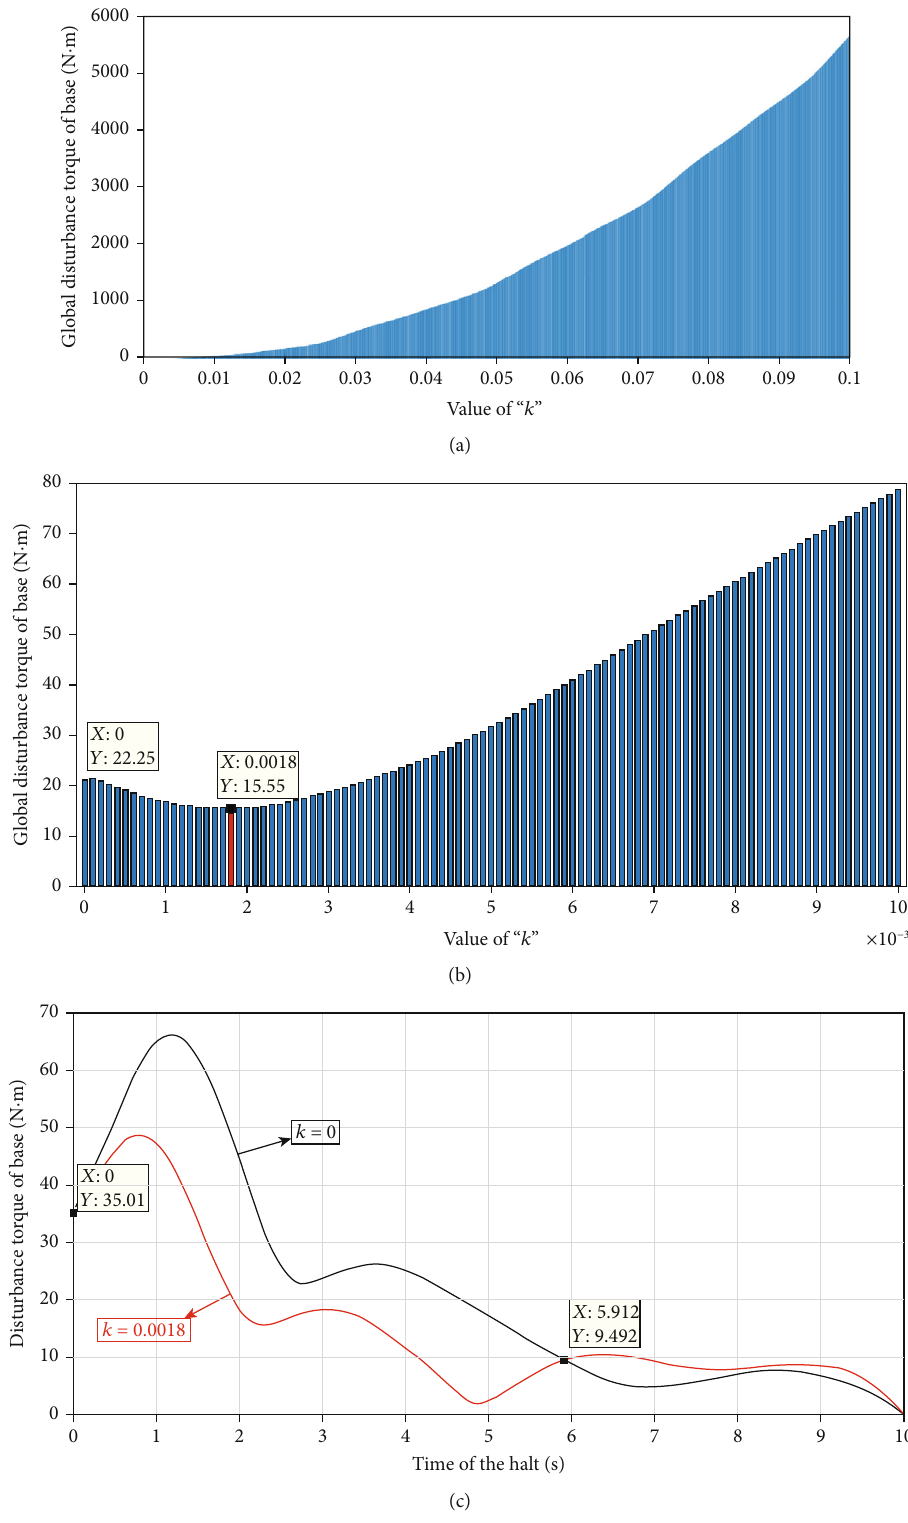
Figure 8: The variations of disturbance torque corresponding to di ff erent k . (a) The variations of disturbance torque when k ∈ ½ 0, 0 : 1 (cid:2) . (b) The variations of disturbance torque when k ∈ ½ 0, 0 : 01 (cid:2) . (c) The comparison of the disturbance torque between optimization and